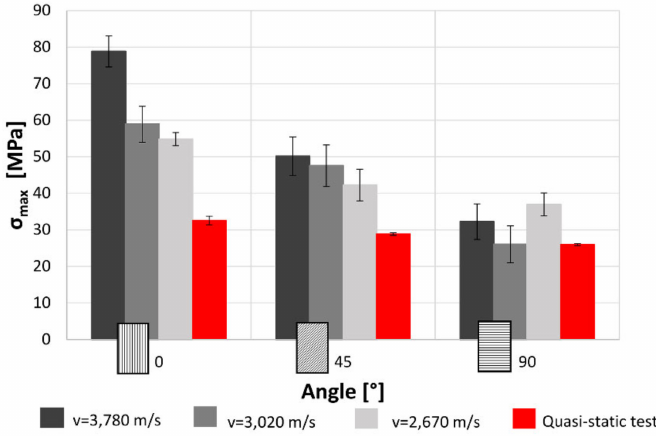
Figure 15. E ff ect on the maximum stress of the raster angles and impact speeds for multilayer specimens.